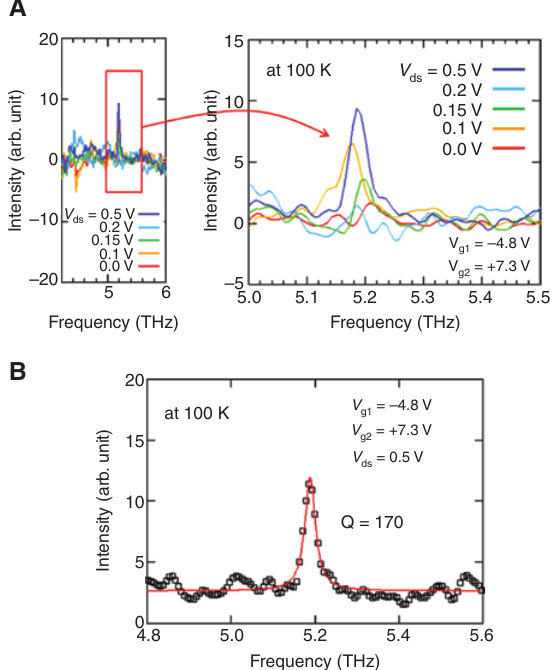
Figure 7: The single-mode like emission peak at ~ 5.2 THz with Q factor of 170 fairly agrees with the simulated results (at ~ 4.96 THz with Q ~ 210). (A) Observed spectra for device 2 at 100 K and (B) the fitting curve for the peak at ~ 5.2 THz showing Q factor to be